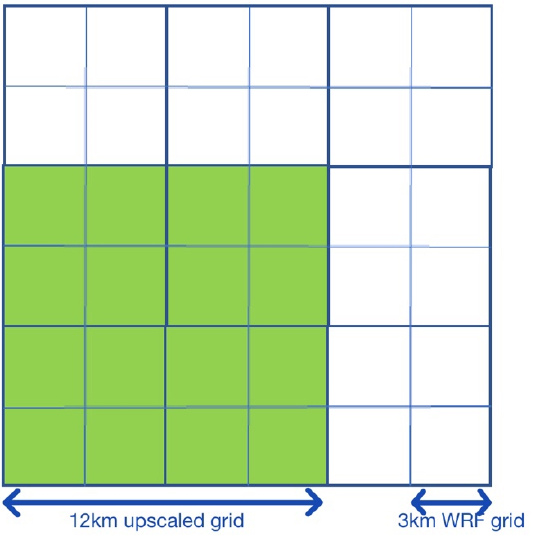
Figure 5. The upscaling of the model output. The green cell has a horizontal resolution of 12 km as a result of applying an upscale factor of 4. The 3 km WRF grid is shown in blue.